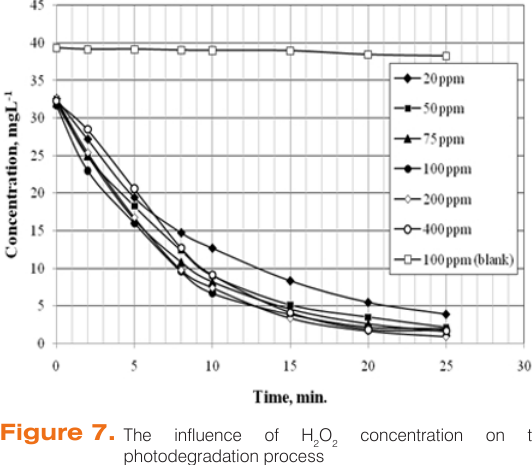
P-25 concentration on the 2